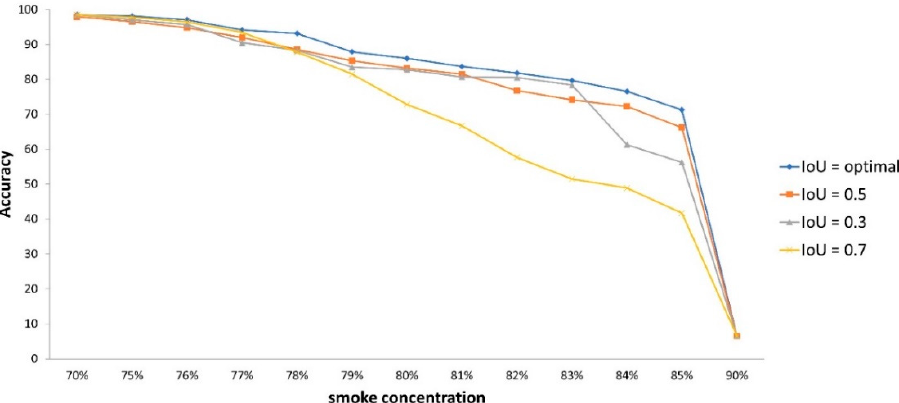
Figure 14. Average accuracy vs. smoke concentration for IoU = 0.3, 0.5, 0.7, and optimal IoU. Table 1. IoU = 0.3, 0.5, 0.7, and average accuracy for optimal IoU values (highlighted in blue) by smoke